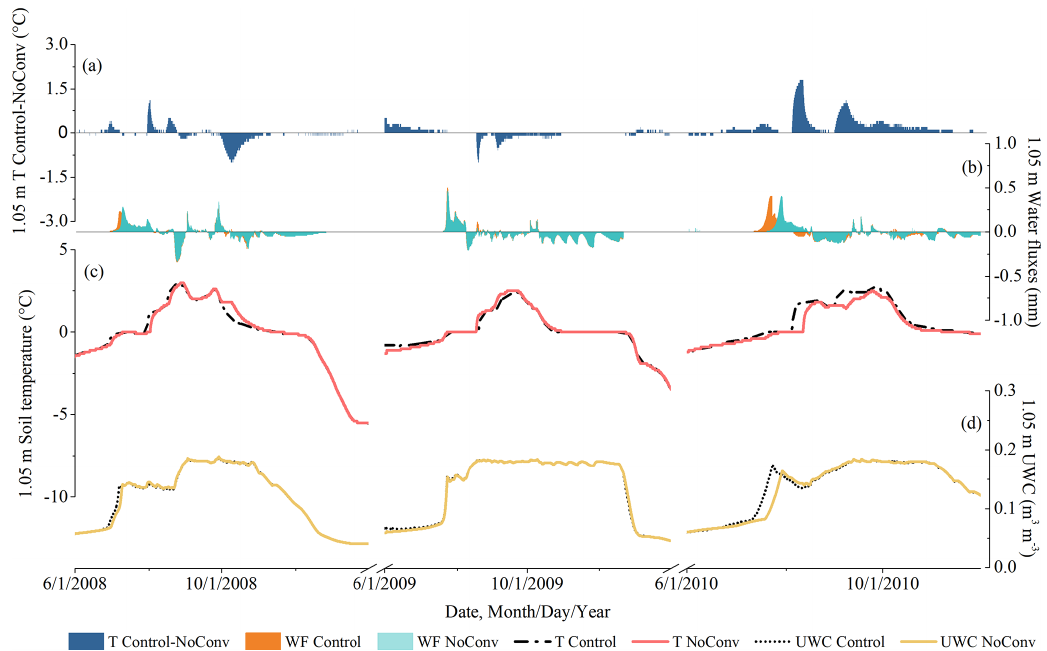
Figure 9. Hourly soil temperature, water flux, and UWC at 1.05m depth simulated under NoConv and Control during the 2008–2010 thaw periods. The same notations as in Fig. 7 are applied.